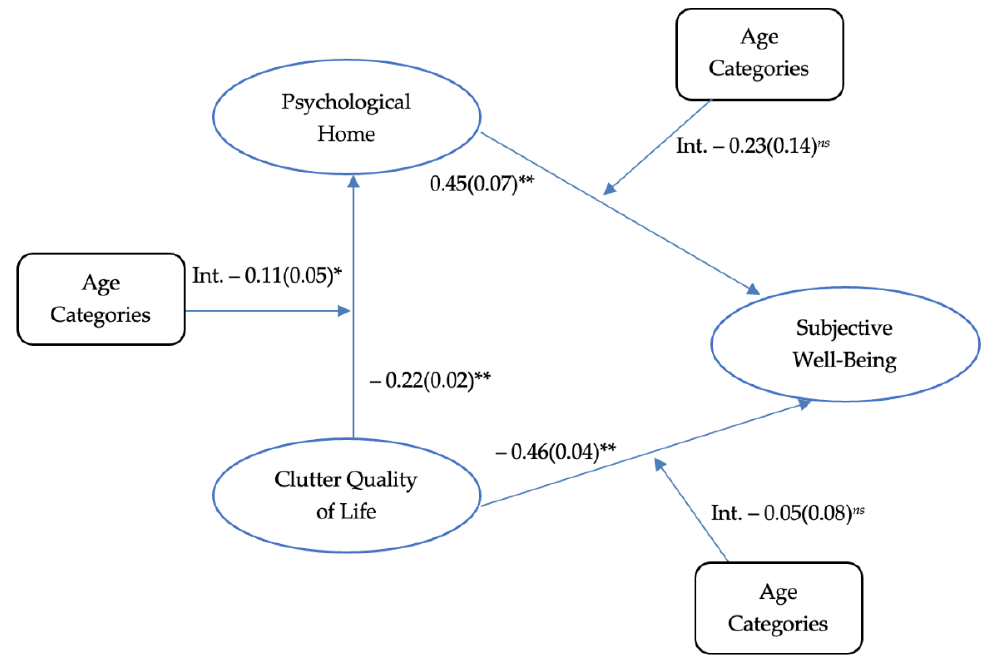
Figure 1. Theoretical Model of Psychological Home with Present Study Coefficients. Note: Direct effect estimates are on the inside of the figure. Interaction effects are indicated with “Int.” before statistics. Statistics presented: β ( SE ). ns = p > 0.05, * p < 0.05, ** p < 0.001